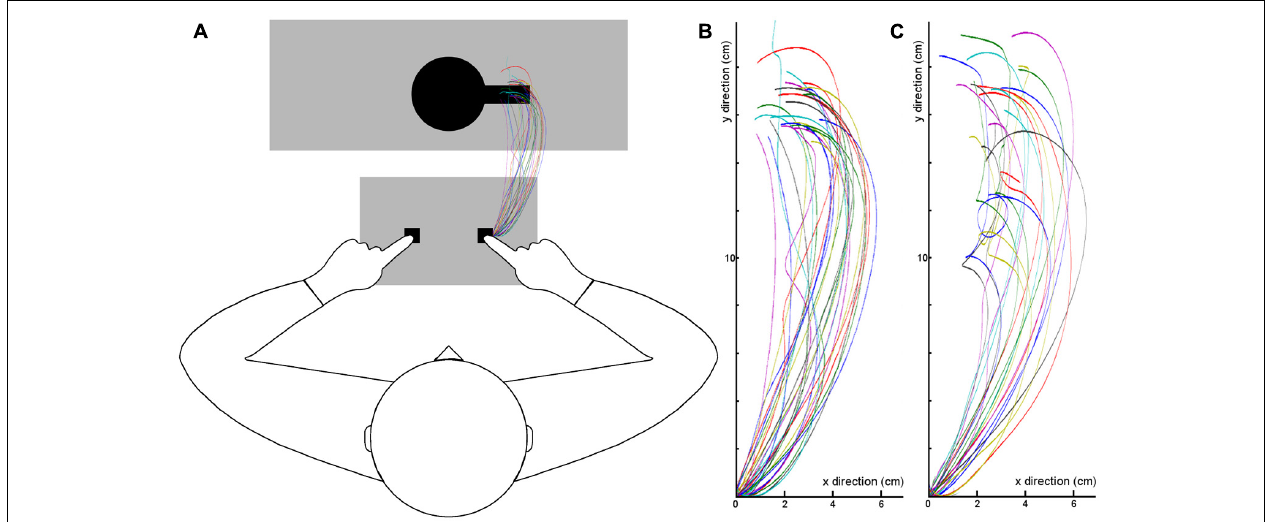
FIGURE 3 | Mean motion trajectories of the index finger for each participant (single lines depict single participants). (A) Trajectories in Experiment 1, plotted into the experimental setup. Participants started their movements from the right key of the button box and moved toward the cup